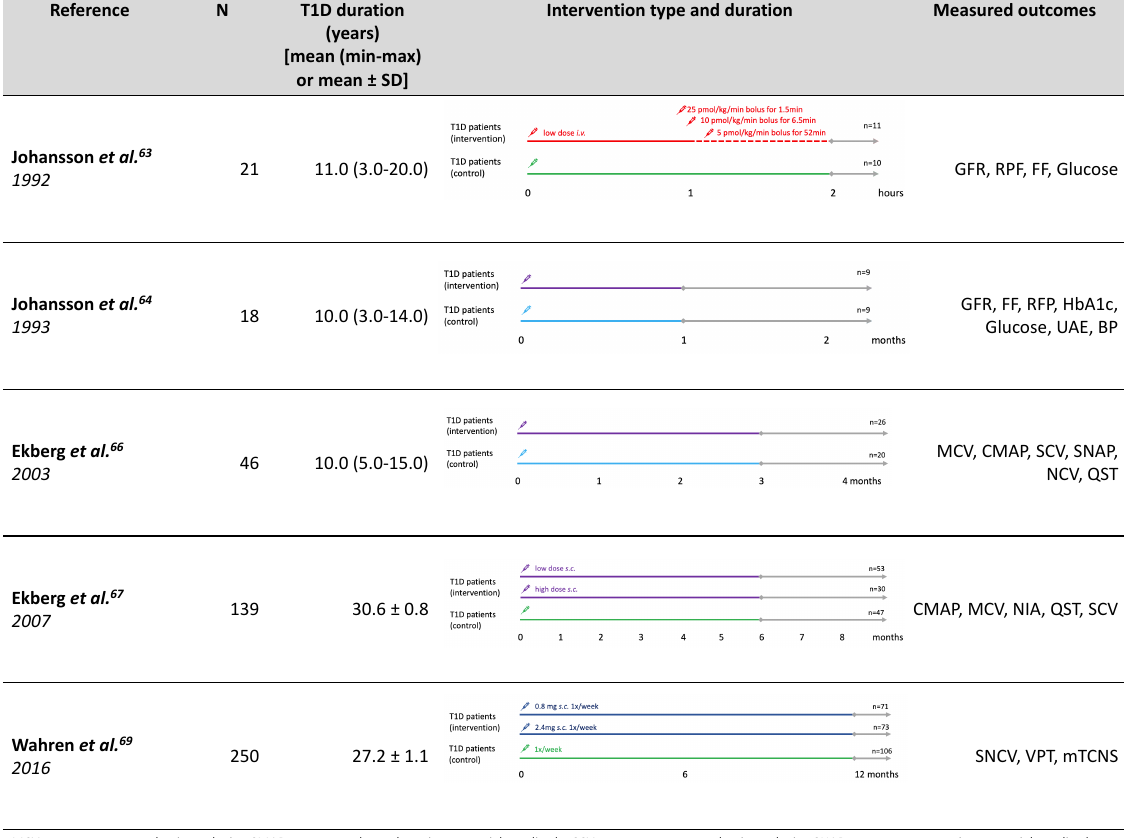
Figure 5. Study design of interventions in